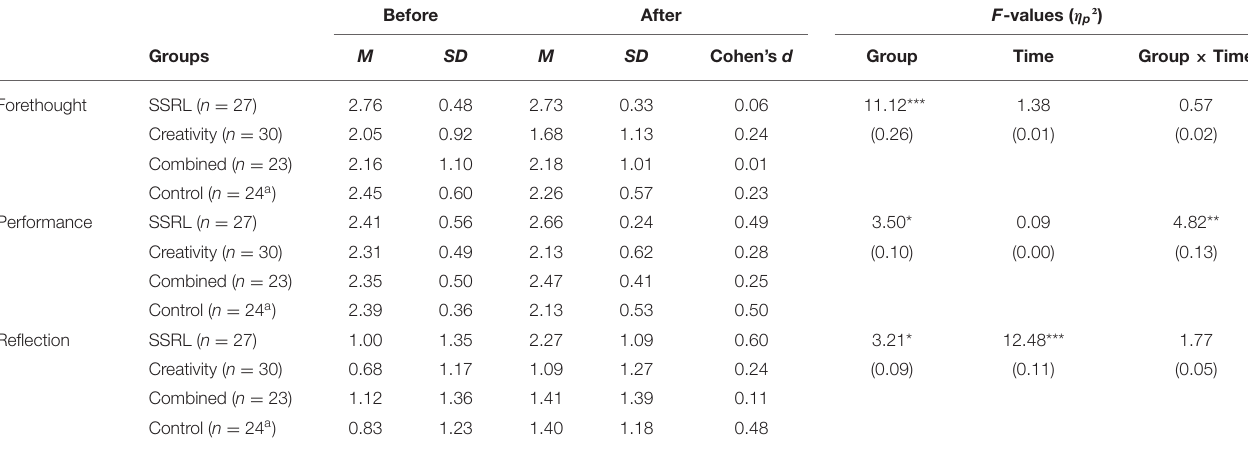
TABLE 4 | Means, SD and F -values for participation in different stages of SSRL during the second part of the task by group and time. Before After F -values ( η p ² ) Groups M SD M SD Cohen’s d Group Time Group ×